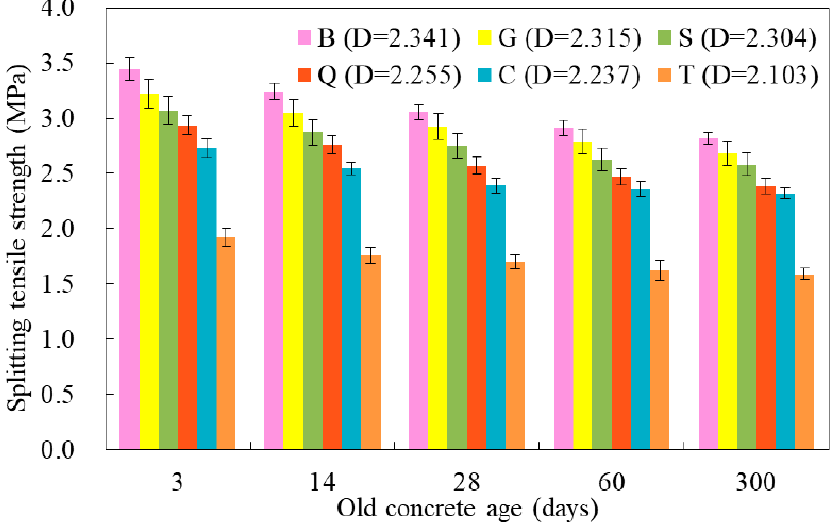
Figure 4. The splitting tensile failure with different ages of old concrete.